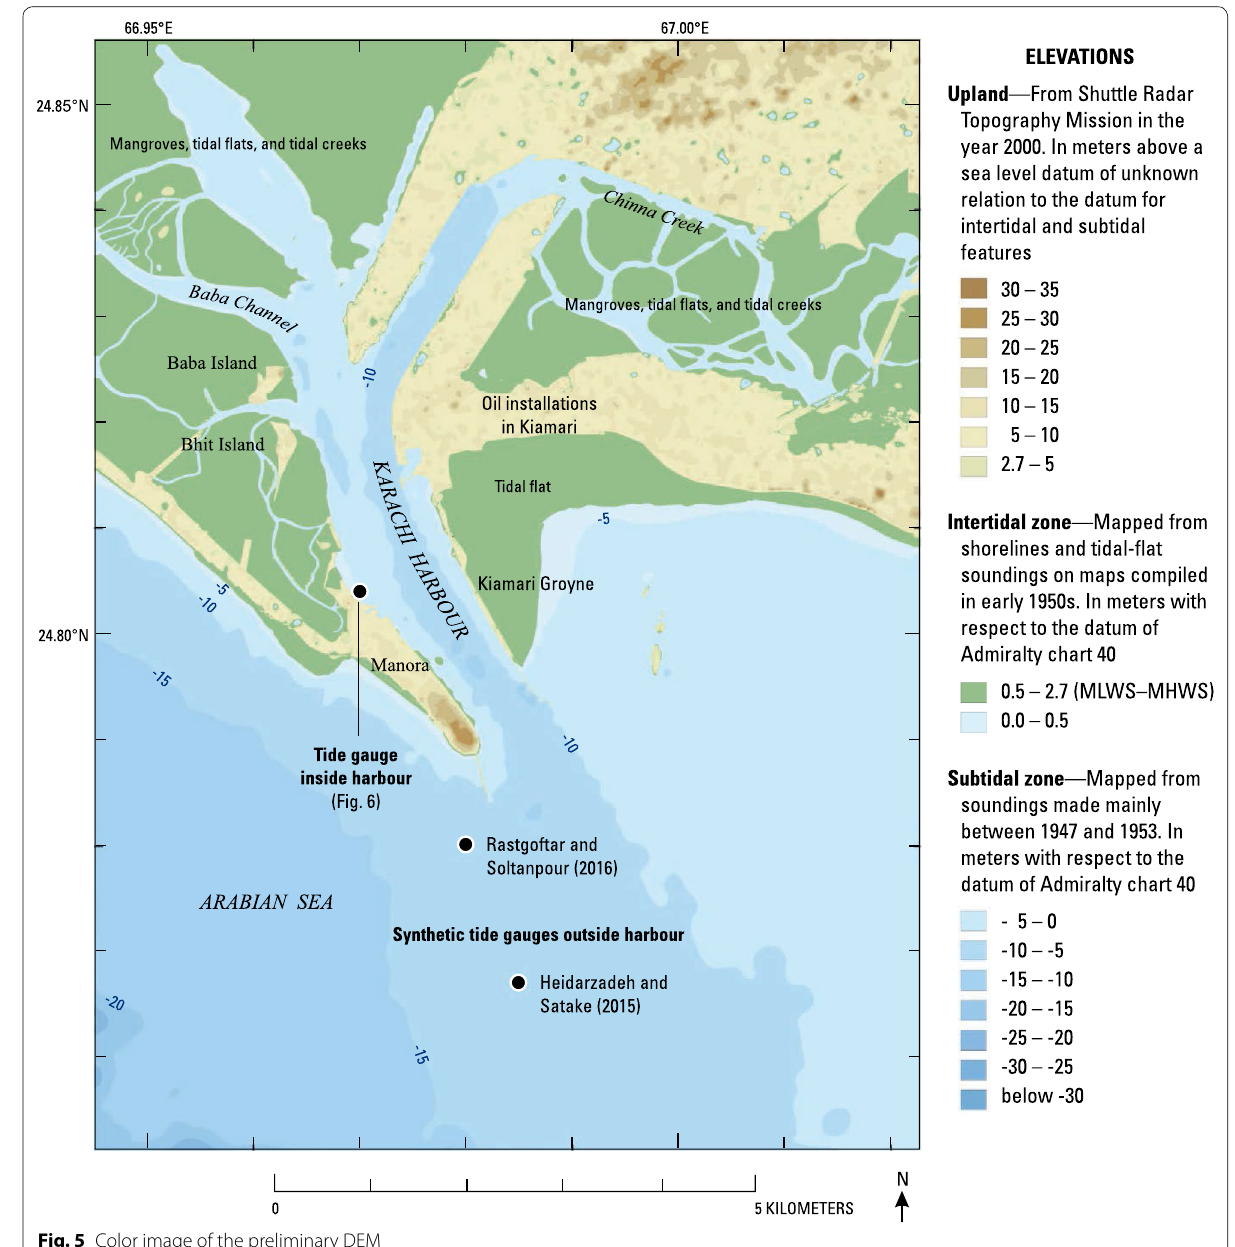
Fig. 5 Color image of the preliminary